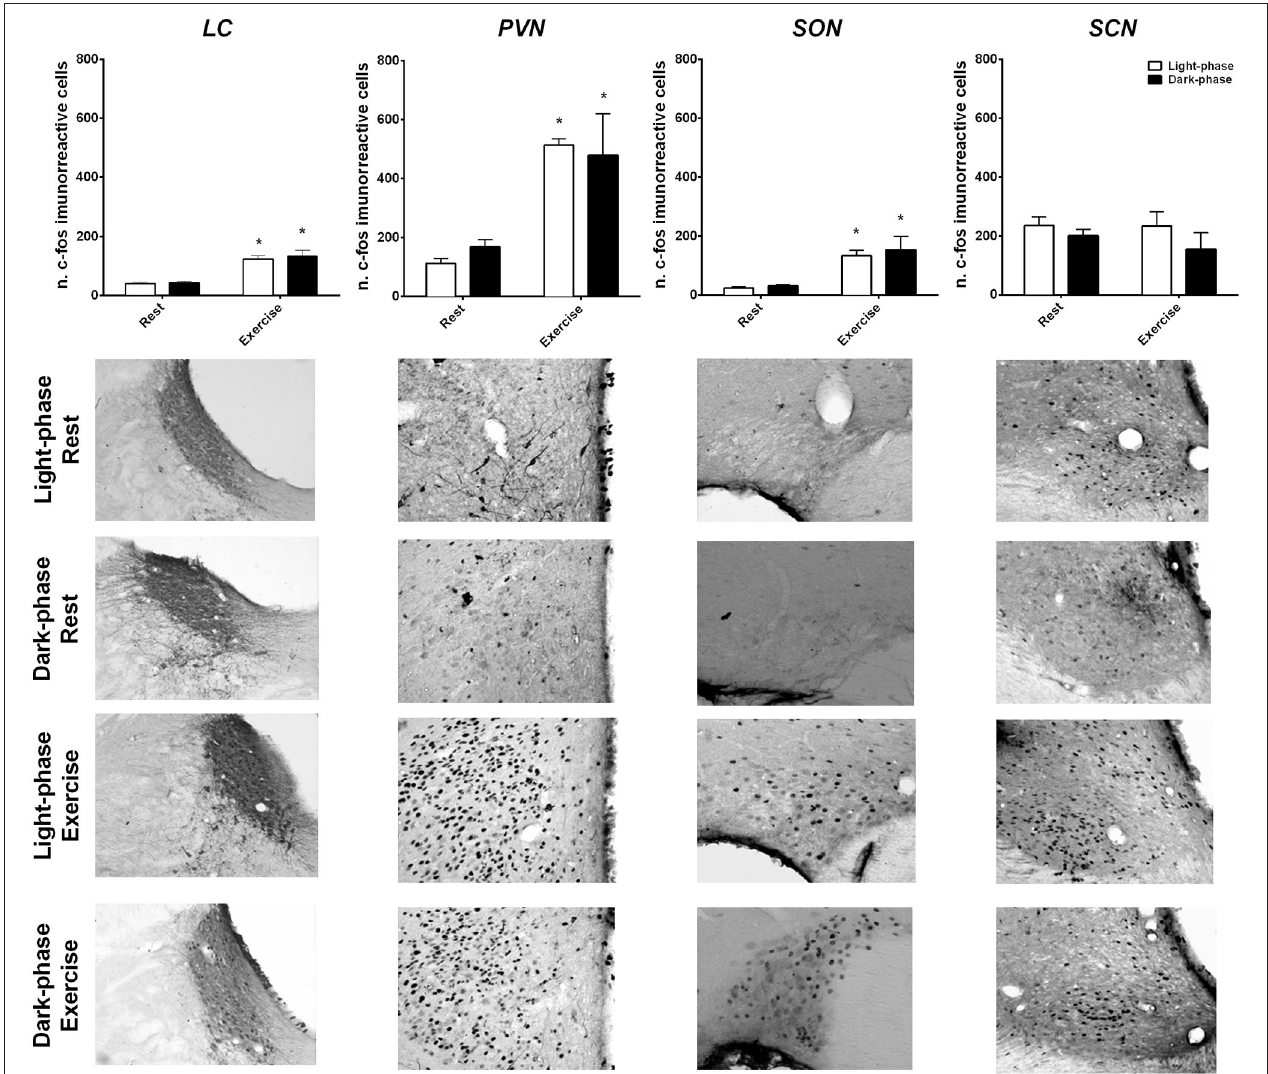
FIGURE 4 | Exercise-induced neuronal activation in the hypothalamus and the brainstem independent of time-of-day. The number of c-fos immunoreactive proteins were quantified and graphically represented after rest and high-intensity exercise conditions during the light (white columns) and dark-phases (black columns). Representative photomicrographs of coronal brain sections (20X) of each nuclei are presented for each condition. The results are expressed as the mean ± SEM ( n = 4–6/group). *Indicates p < 0.05 between rest and